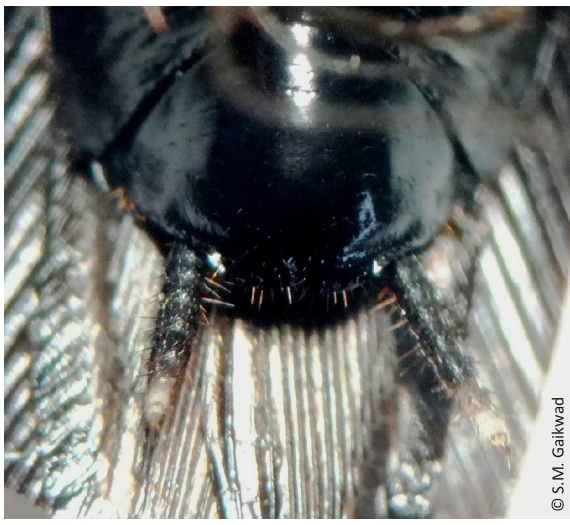
Image 5. Hemithyrsocera palliata - abdomen showing subgenital